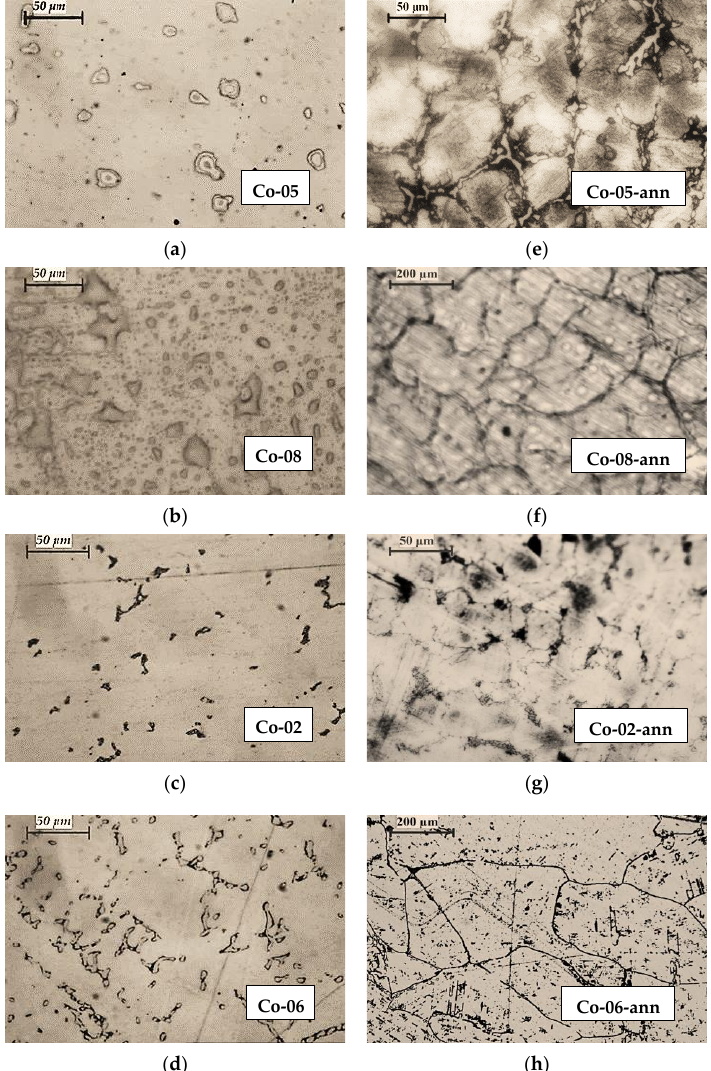
Figure 3. Microstructures of CoCrMo ingots recycled by EBMR: ( a ) Co - 05; ( b ) Co - 08; ( c ) Co - 02; ( d ) Co - 06 (400× magnification); and their microstructures after heat treatment: ( e ) Co - 05 - ann (400× magnification); ( f ) Co - 08 - ann (100× magnification); ( g ) Co - 02 - ann (400× magnification); ( h ) Co - 06 - ann (100× magnification).